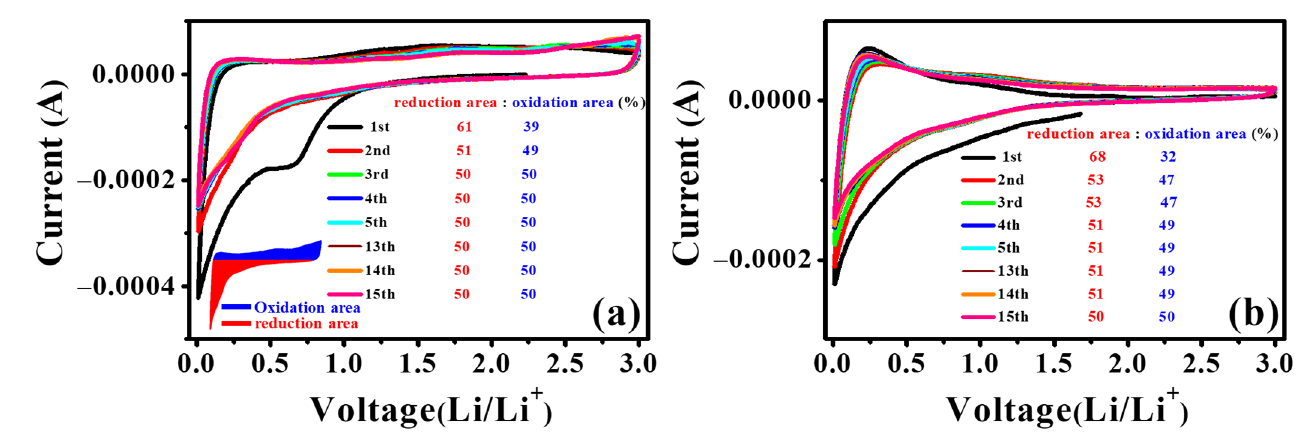
Figure 13. Area covered under the CV curves of ( a ) MRGO-HS and ( b ) RGO. CV measurements were made at various sweep speeds of 0.1, 0.3, 0.5, and 0.8 mV/s, thereby comparing the dynamics of MRGO-HS and RGO to further investigate their ca- pacitive behaviors. The CV curve at each sweep rate showed a similar shape (Figure 14a,b). The relationship between the current ( i ) to be measured and the scan speed ( ν ) is expressed by Equations (2) and (3).